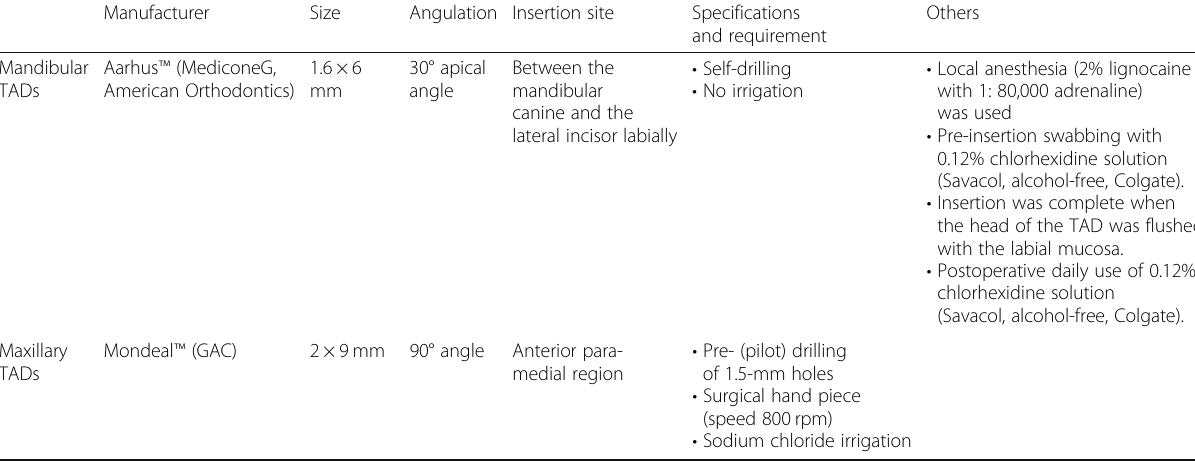
Table 1 Skeletal anchorage